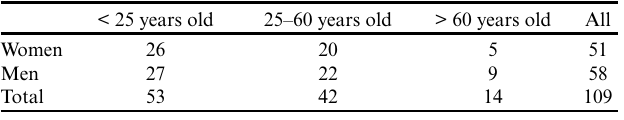
Table 1 . Age and gender details of